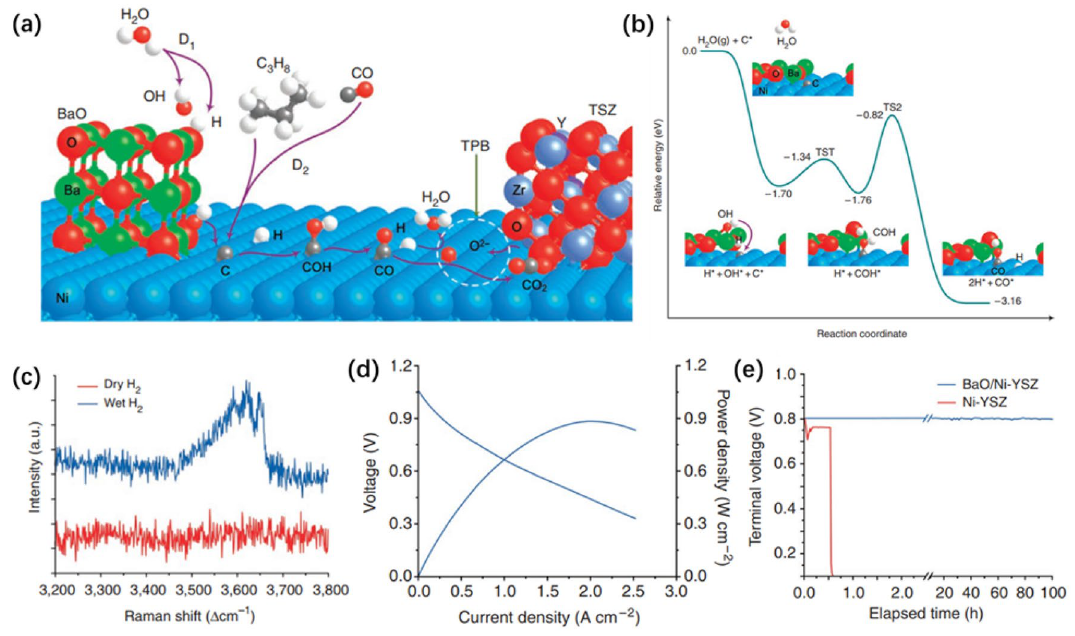
Fig. 4 a Proposed mechanism for water-mediated carbon removal on the anode with BaO/Ni interfaces. b DFT predication for the removal of chemisorbed carbon species energies. c Raman spectra collected from BaO/Ni samples in dry and wet H 2 (with ~ 3%H 2 O) atmospheres at room temperature. d I–V plots of button cell with the configuration